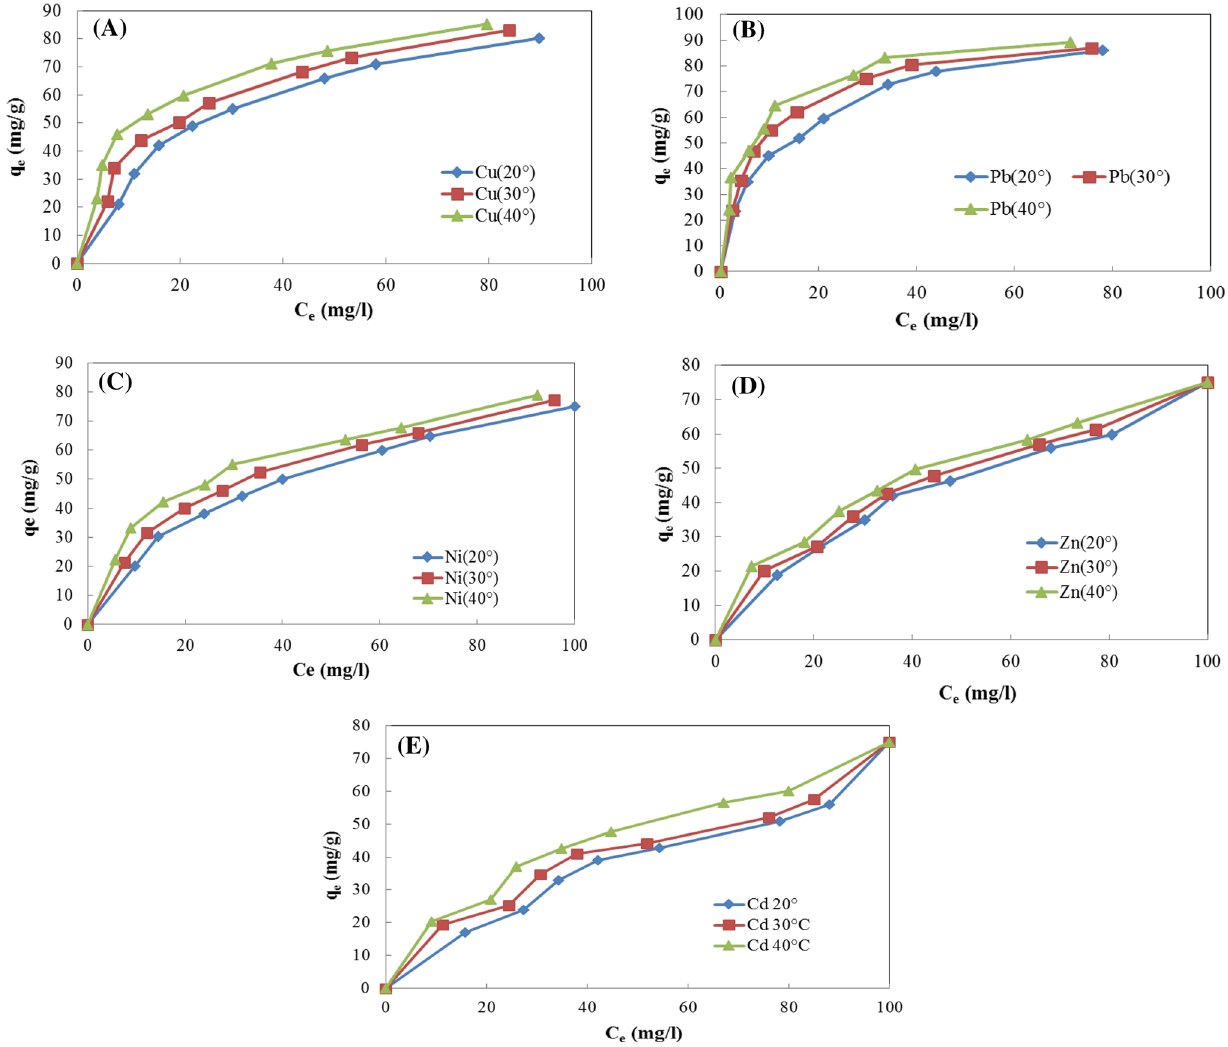
Fig. 9 Effect of the temperature on the adsorption of five heavy metals by Posidonia